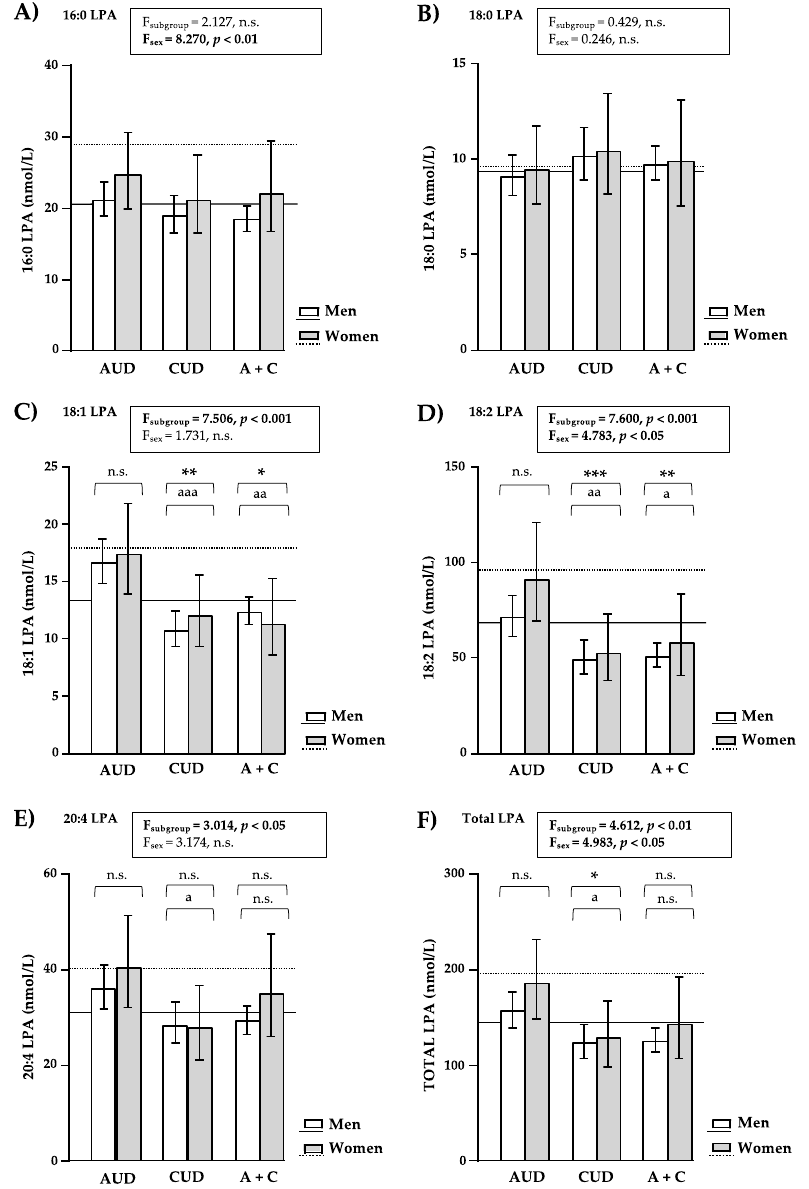
Figure 2. Plasma concentrations of LPA species and total LPA in the sample based on the sample subgroup and sex factors. ( A ) 16:0-LPA concentrations; ( B ) 18:0-LPA concentrations; ( C ) 18:1-LPA concentrations; ( D ) 18:2-LPA concentrations; ( E ) 20:4-LPA concentrations; and ( F ) total LPA concentrations (nmol/L). Log10-transformed concentrations of LPA species and total LPA were analyzed using two-way ANCOVA with sample subgroup (the AUD, CUD, AUD + CUD subgroups and the control group) and sex (women and men) as factors while controlling for age and BMI. The bars represent the estimated marginal means and 95% CI after back-transformation. The horizontal lines represent the estimated marginal means after back-transformation of women (dotted) and men (straight) in the control group. F-statistics and p -values of ANCOVA are shown. (*) p < 0.05, (**) p < 0.01 and (***) p < 0.001 denote significant differences compared with the control group. (a) p < 0.05, (aa) p < 0.01 and (aaa) p < 0.001 denote significant differences compared with the AUD subgroup. (n.s.) p > 0.05 denotes no significant